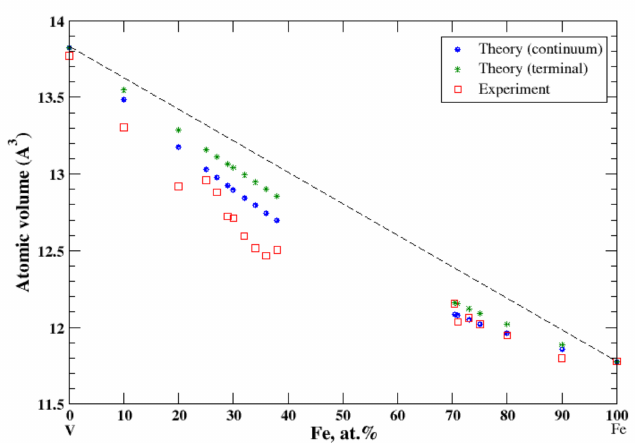
Figure 14. Atomic volume vs. concentration for Fe-V alloy system. The experimental data are from Ref. [16] (p. 634 and p. 663).